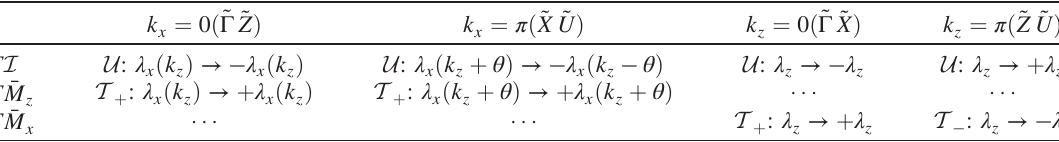
π , it is energy dependent as well; that is, λ x ¼ and energy θ . z